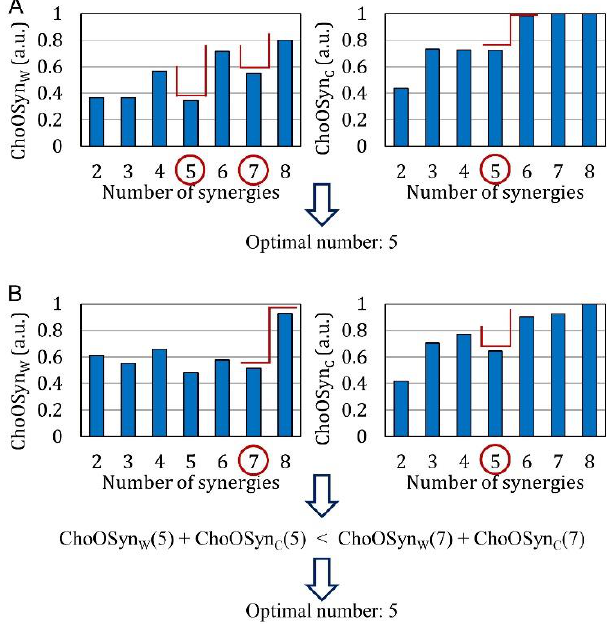
Figure 3. Examples of ChoOSyn W and ChoOSyn C values calculated on muscle synergies extracted from the data of two representative real subjects. “Steps” and local minima are highlighted by red segments. These examples show how the optimal number of synergies is chosen when the outputs of the two parameters are ( A ) the same or ( B ) different.